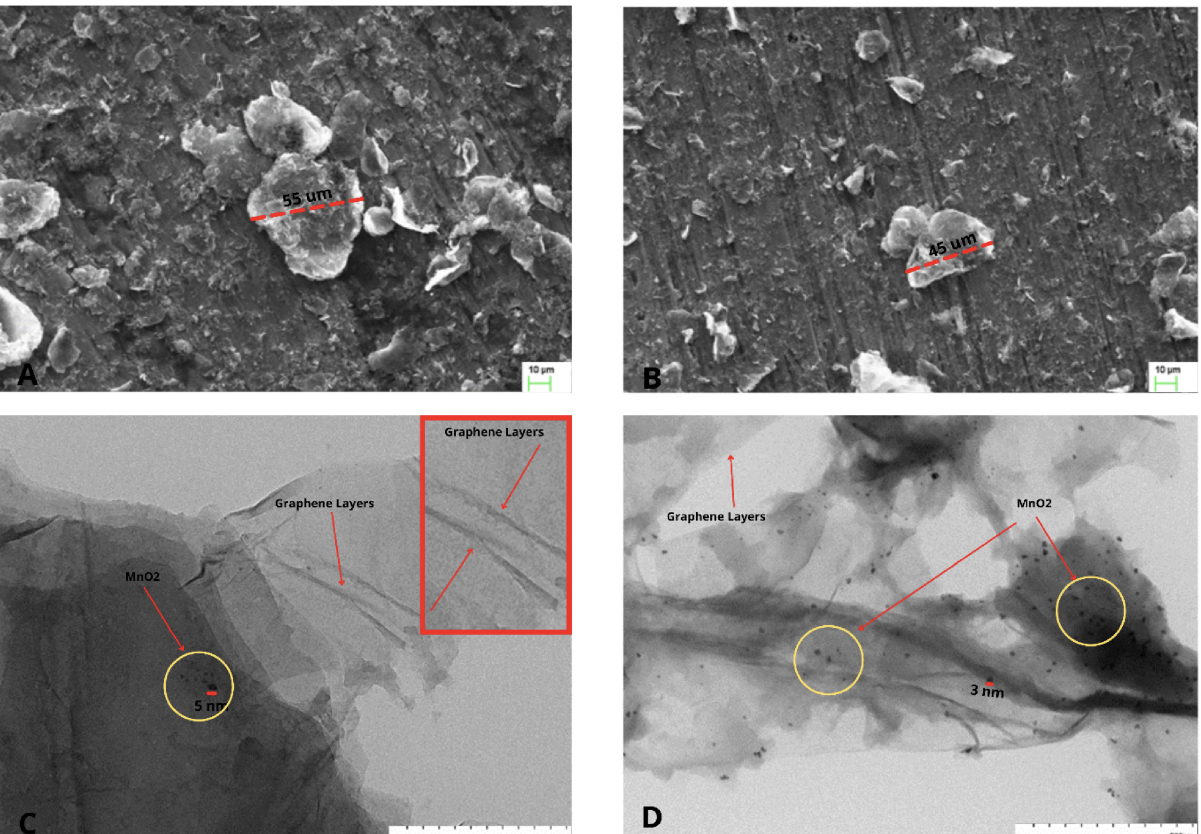
Figure 7. ( A ) SEM image of the MnO 2 /rGO nanocomposite; ( B ) SEM image of the MnO 2 AsA/rGO nanocomposite; ( C ) TEM image of the MnO 2 /rGO nanocomposite; ( D ) TEM image of the MnO 2 AsA/rGO